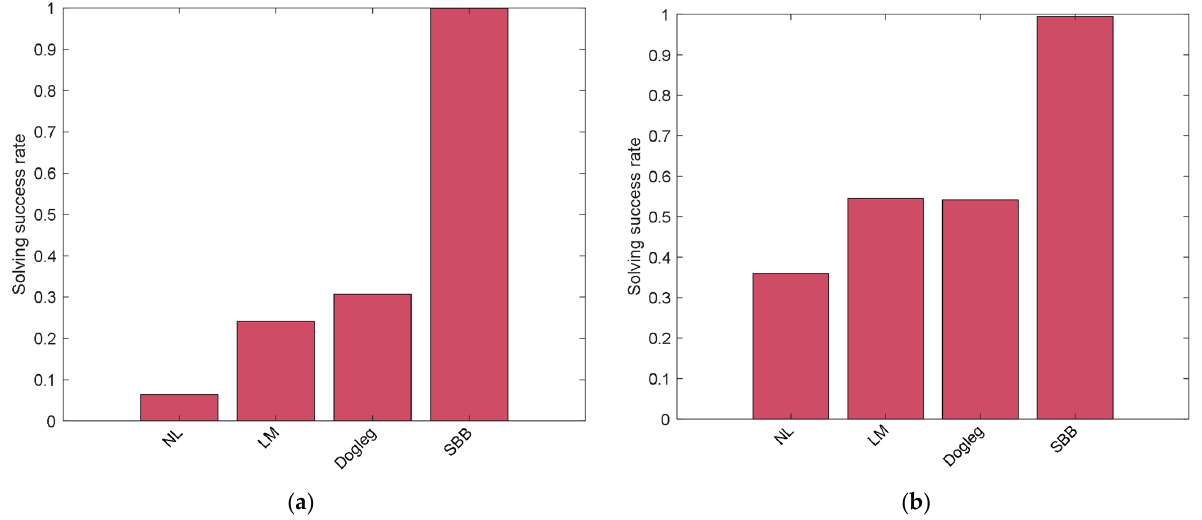
Figure 11. Statistical chart of success rate of different algorithms. ( a ) x 0 ∈ D ; ( b ) x 0 ∈ D s